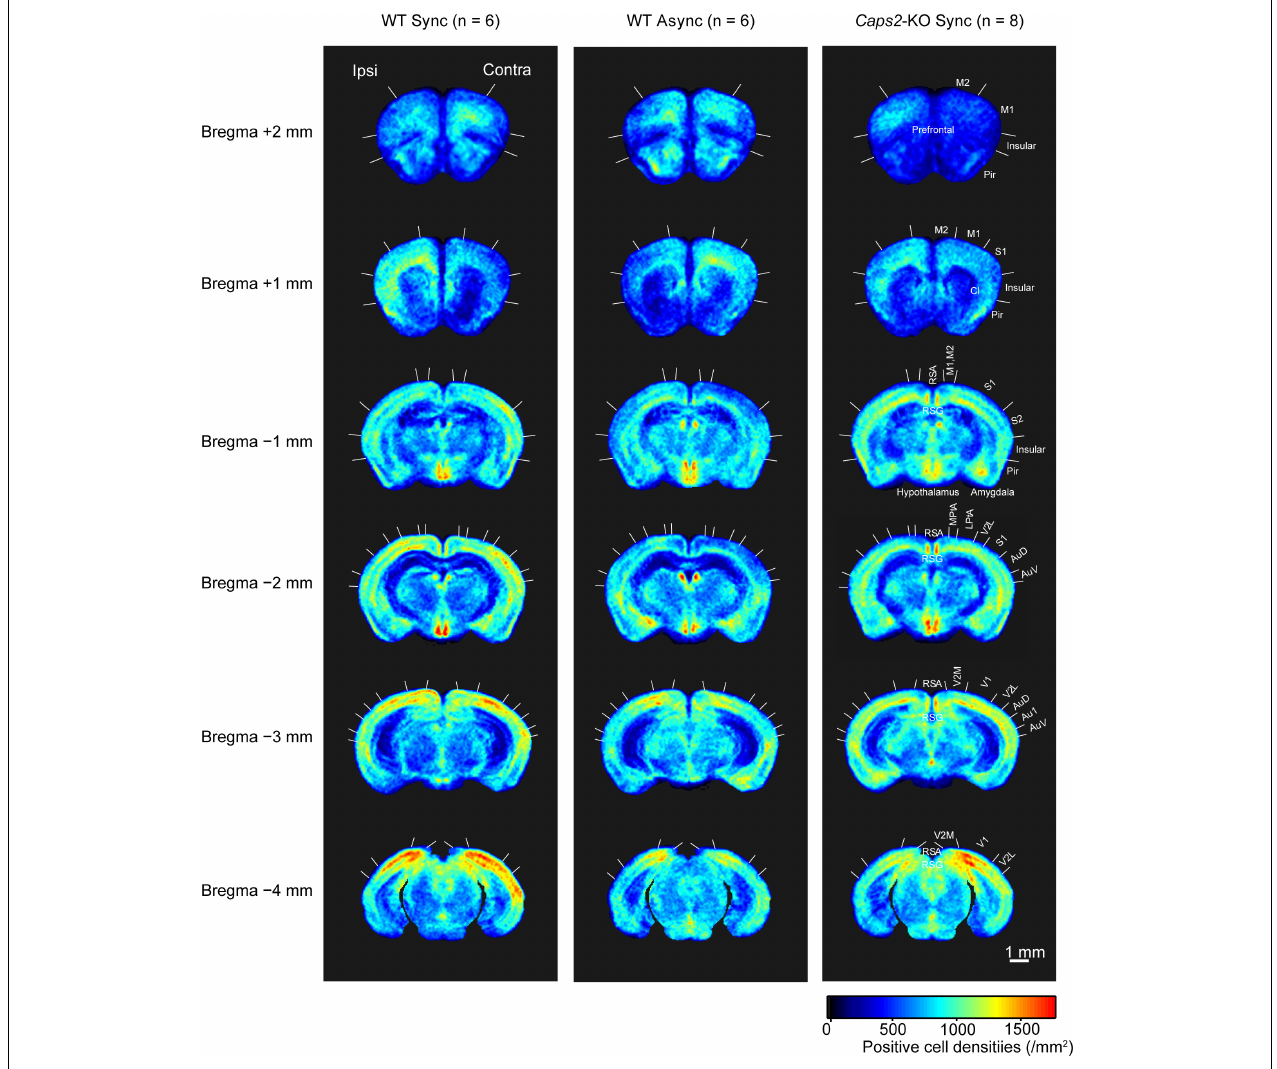
FIGURE 2 | c-Fos-positive cell density maps (PCDM). PCDMs corresponding to six different levels (bregma +2, +1, − 1, − 2, − 3, and − 4 mm) are shown in rows for each group (columns: WT with Asynchronous condition, WT with Synchronous condition, Caps2 -KO with Synchronous condition). Each PCDM map was aligned according to the side of the rubber tail and combined. Boundaries between regions were determined by reference to the brain atlas (Paxinos and Franklin, 2001). M2, secondary motor cortex; M1, primary motor cortex; Pir, Piriform cortex, SI, primary somatosensory cortex; S2, secondary somatosensory cortex; RSA, retrosplenial agranular cortex; RSG, retrosplenial granular cortex; MPtA, medial parietal association cortex; LPtA, lateral parietal association cortex; Au1, primary auditory cortex; AuD, secondary auditory cortex dorsal area; AuV, secondary auditory cortex ventral area; V1, primary visual cortex; V2M, medial secondary visual cortex; V2L, lateral secondary visual cortex. Scale bar: 1